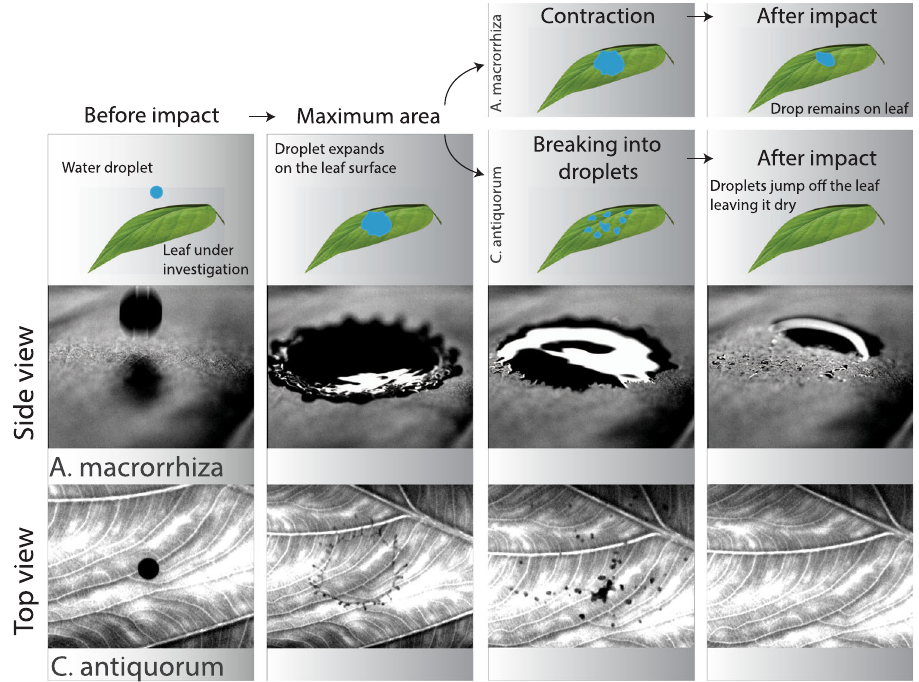
Fig. 2 Wetting behavior of the two model species. High-speed camera snapshots of the interaction between a water droplet and the surface of A. macrorrhiza and C. antiquorum leaves and illustrations of the different behavior of the two species. Videos of the droplet impact are given in Supplementary Movie